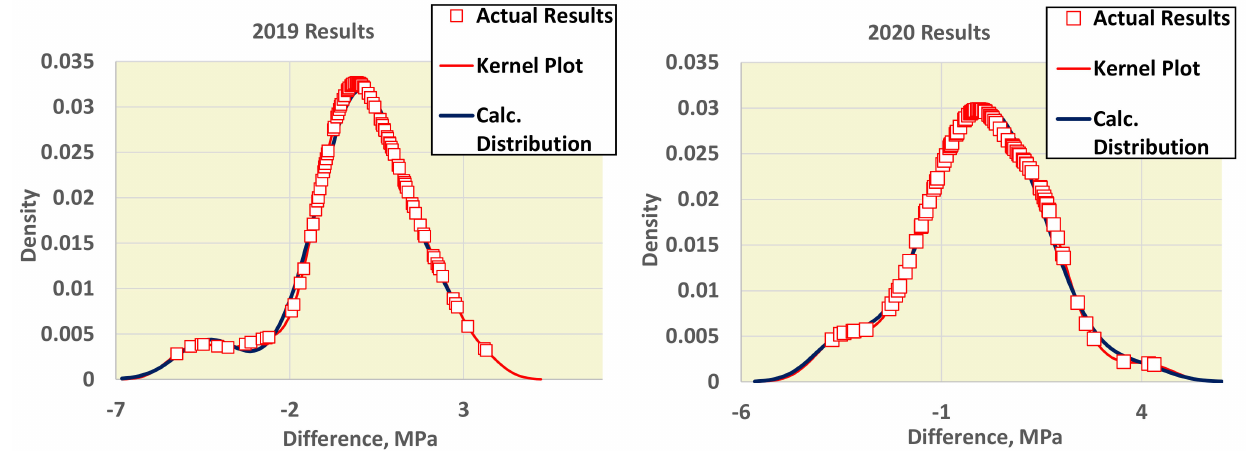
Figure 2. Actual distributions, kernel plots, and calculated distributions for all the yearly